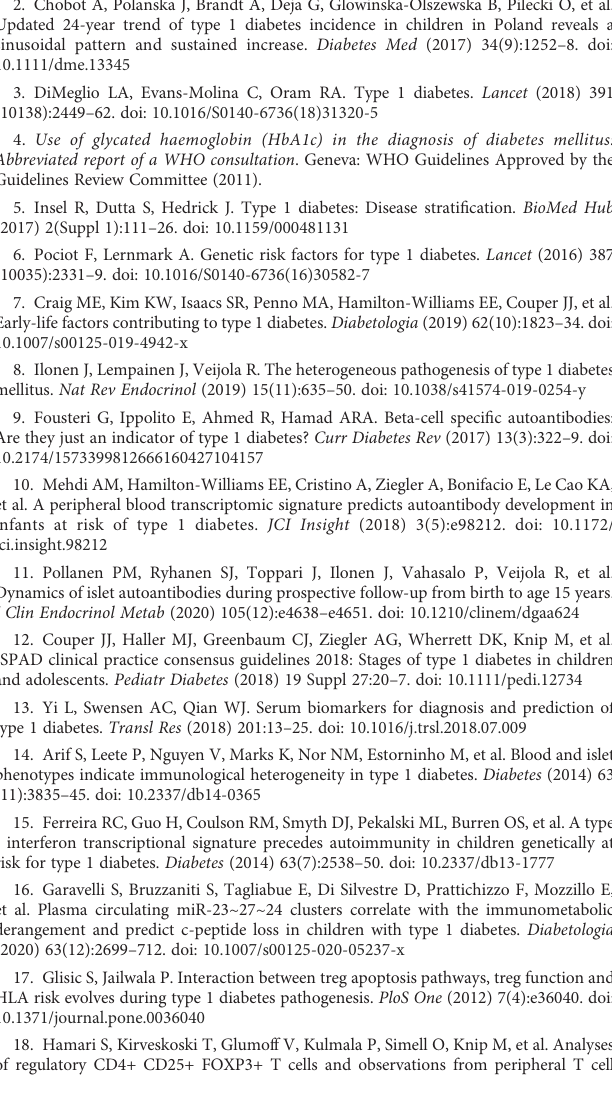
Figure 2 made using